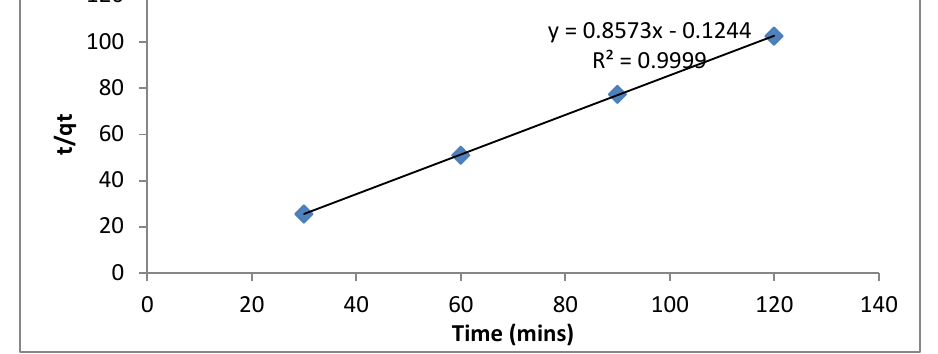
Figure 10: Pseudo second order for cadmium removal by banana peel biomass